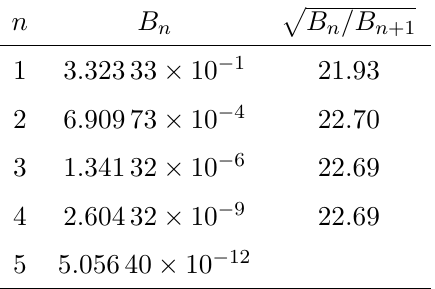
condensing towards the three-particle threshold, emerges in the non-relativistic theory